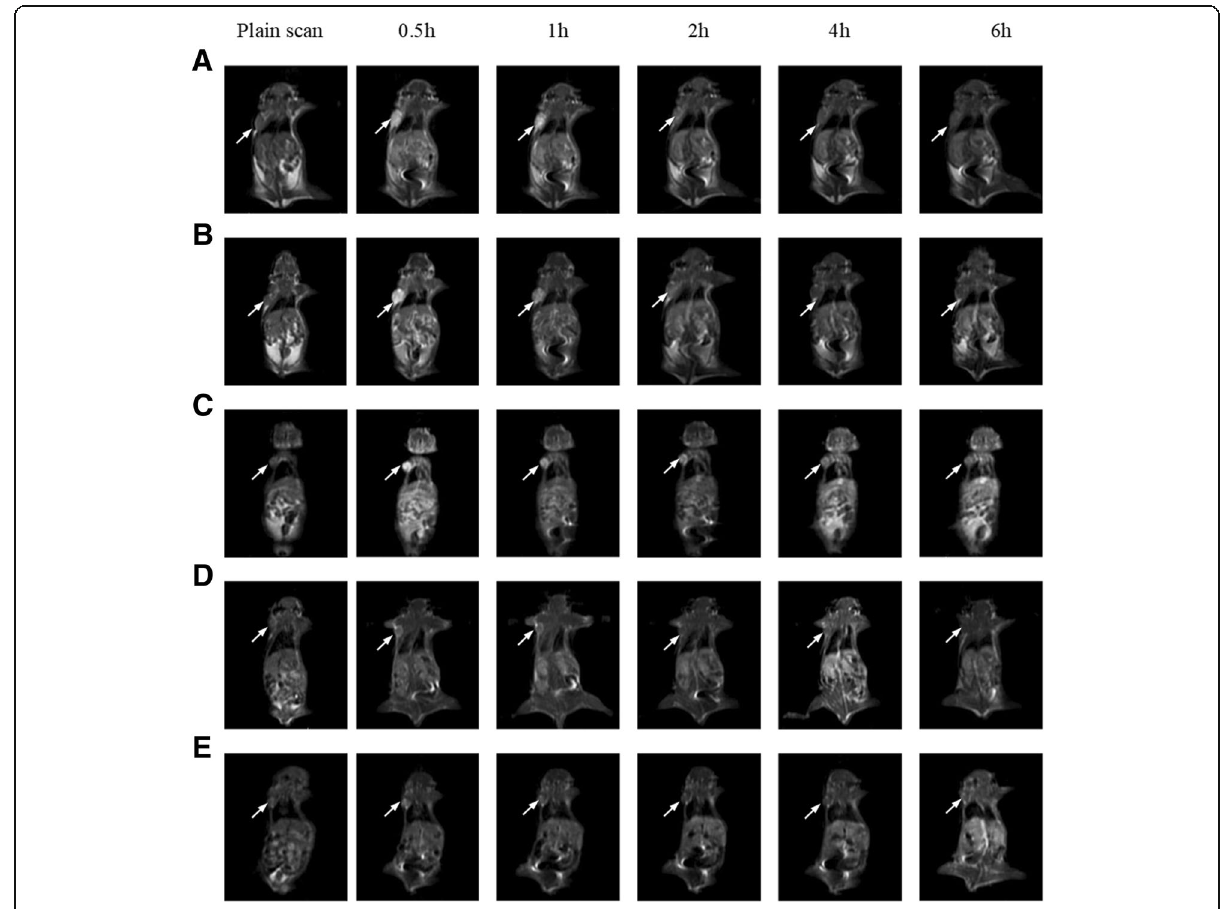
Fig. 3 MR images of tumor-bearing mice before and after injection with different contrast agents in different time points. a pure Gd-DTPA. b Gd- LP. c P1-Gd-LP. d P2-Gd-LP. e